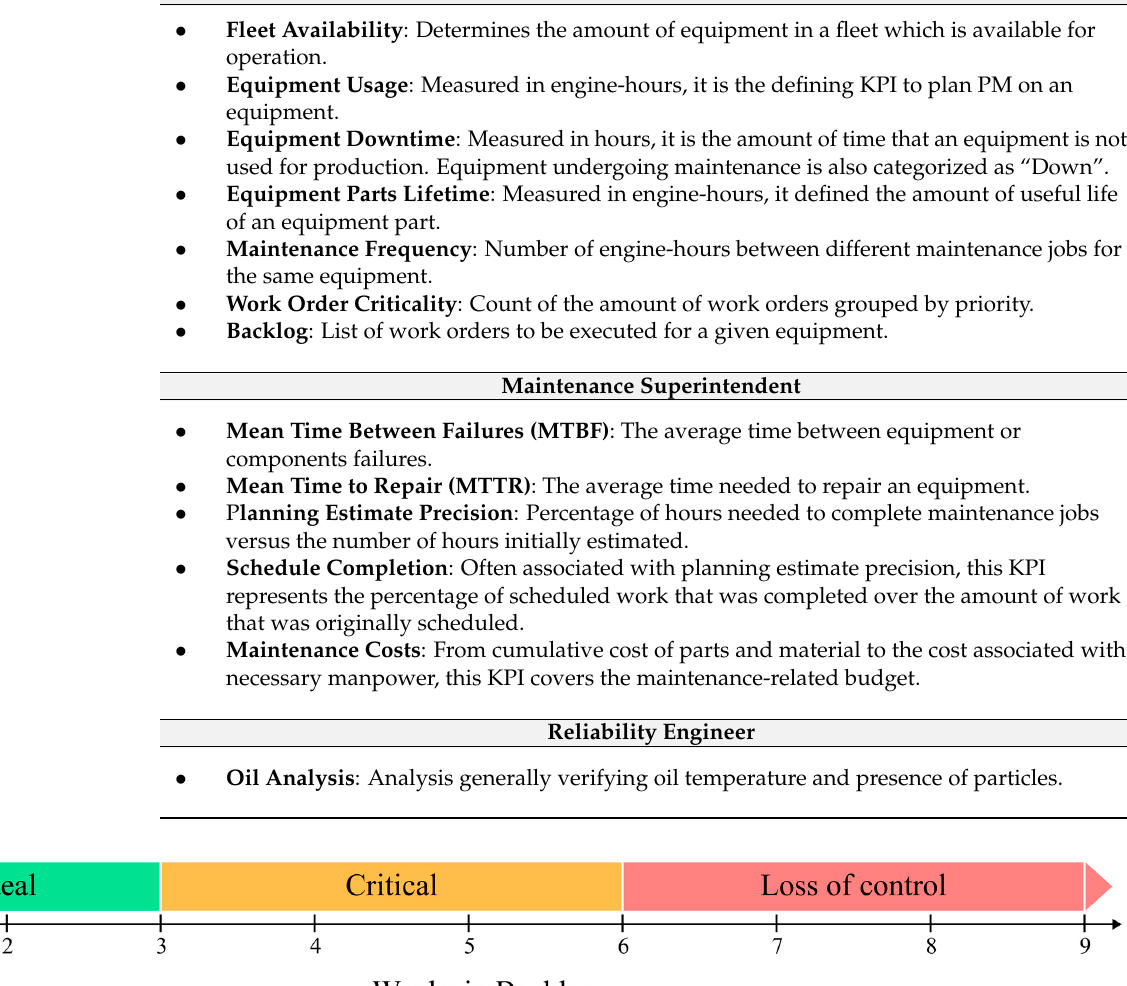
Maintenance Planner